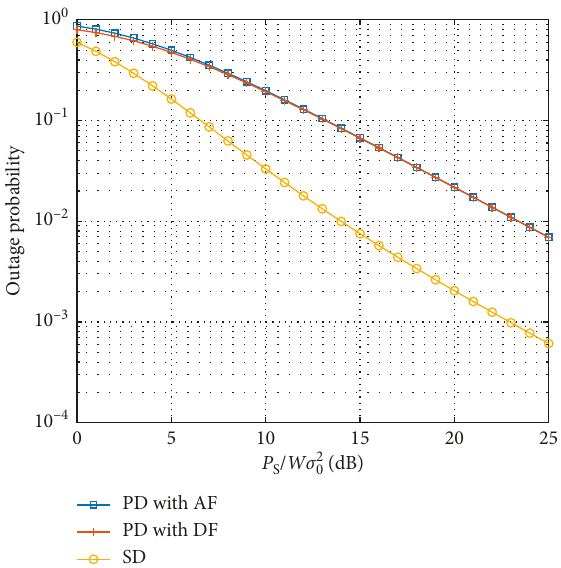
Figure 2: System outage probability vs. P � 10000bps, and P � 0 . 0632W). R th